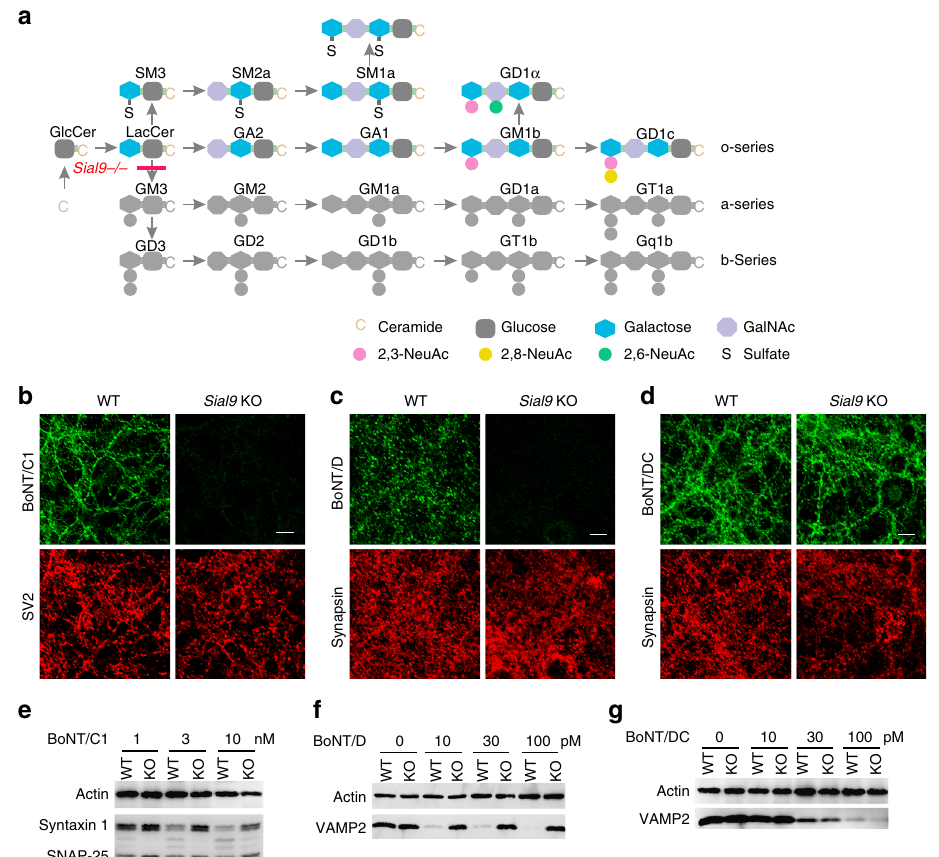
Fig. 1 Lacking both a-series and b-series of complex gangliosides reduced binding and entry of BoNT/C1 and D into neurons, but did not affect BoNT/DC. a A schematic drawing of ganglioside synthesis pathways, with the step blocked in Sial9 KO mice marked. b WT and Sial9 KO cortical neurons were exposed to BoNT/C1 (100 nM, 5 min in High-K + buffer). Cells were washed, fi xed, and subjected to immunostaining analysis using a polyclonal anti-BoNT/C1 antibody (green). SV2 was co-stained in parallel using a pan-SV2 monoclonal antibody (red) to mark presynaptic terminals. Binding of BoNT/C1 is largely abolished in Sial9 KO neurons. Scale bar here and thereafter represents 20 µ m. c Experiments were carried out as described in b , except that neurons were exposed to HA-tagged BoNT/D-H C (100 nM). Binding of BoNT/D-H C was detected with a monoclonal HA antibody (green). Synapsin was co-stained to mark presynaptic terminals (red). Binding of BoNT/D-H C is largely abolished in Sial9 KO neurons. d Experiments were carried out as described in c , except that neurons were exposed to HA-tagged BoNT/DC-H C (100 nM). BoNT/DC-H C binds equally well to WT and Sial9 KO neurons. e WT and Sial9 KO neurons were exposed to the indicated concentrations of BoNT/C1 (5 min in High-K + buffer). Neurons were washed and further incubated in toxin-free medium for 8 h. Neurons were harvested and cell lysates were subjected to immunoblot analysis. Cleavage of SNAP-25 by BoNT/C1 generates a slightly smaller fragment, marked with an asterisk. Entry of BoNT/C1 into Sial9 KO neurons was reduced, as there is less cleavage of SNAP-25 and syntaxin 1. f , g Experiments were carried out as described in e , except that neurons were exposed to BoNT/D ( f ) or BoNT/DC ( g ). Cleavage of VAMP2 by BoNT/D or BoNT/DC results in disappearance of its immunoblot signals. Entry of BoNT/D into Sial9 KO neurons was blocked, as there was no cleavage of VAMP2 in Sial9 KO neurons. Entry of BoNT/DC into WT and Sial9 KO neurons was at similar levels. One of two ( b – d ) or three ( e – g ) independent experiments is